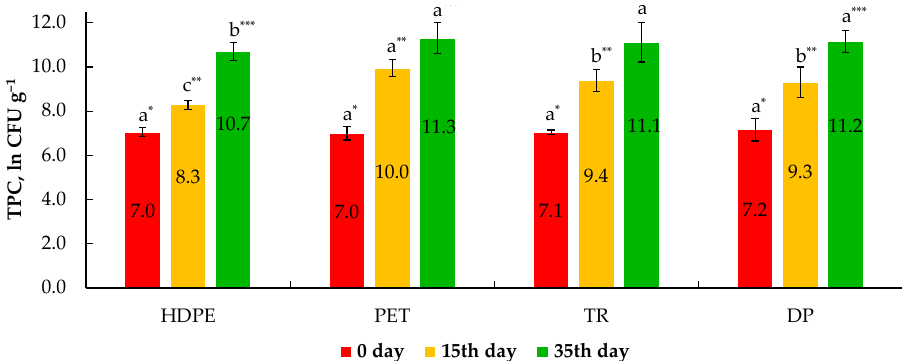
Figure 4. Total plate count growth dynamics during liquid whole egg product storage for 35 days in four types of packaging. Note: Values are means ± SD of triplicates ( n = 3). Means within the same